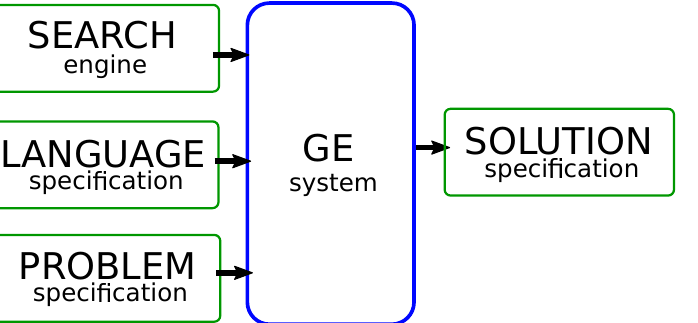
Figure 3. The grammatical evolution (GE) system utilizes a search engine (commonly a genetic algorithm) to generate new solutions for a specific issue by combining genetic material (genotype) and converting (mapping) it into programs (phenotype) in accordance with a language specification (interpreter/compiler).